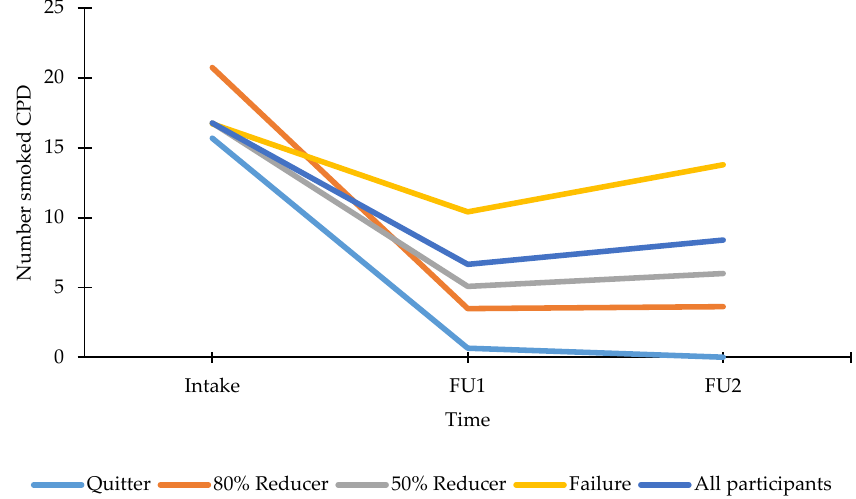
Figure 3. Smoked CPD at intake, FU1, FU2 for all participants and reduction rate groups as calculated